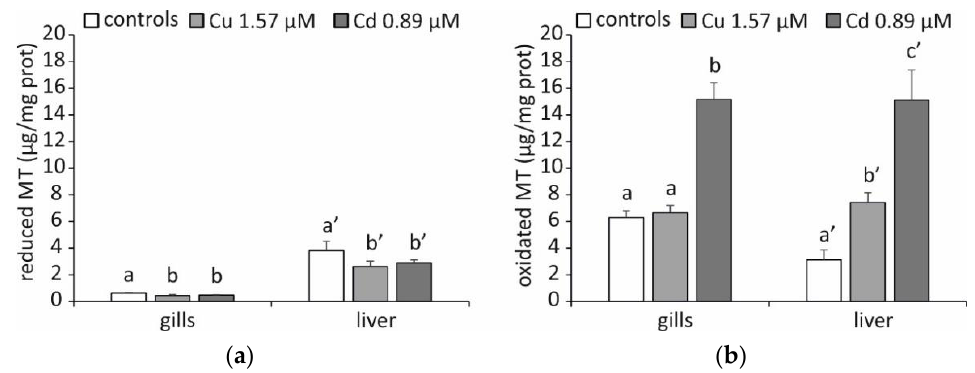
Figure 3. MT content (μg/mg total proteins) in gills and liver of T. hansoni . The results are expressed as the mean of five specimens ± SD. Different letters with the same index correspond to significant statistical differences among the different experimental conditions for p < 0.05. ( a ) Reduced MTs; ( b ) oxidized MTs.